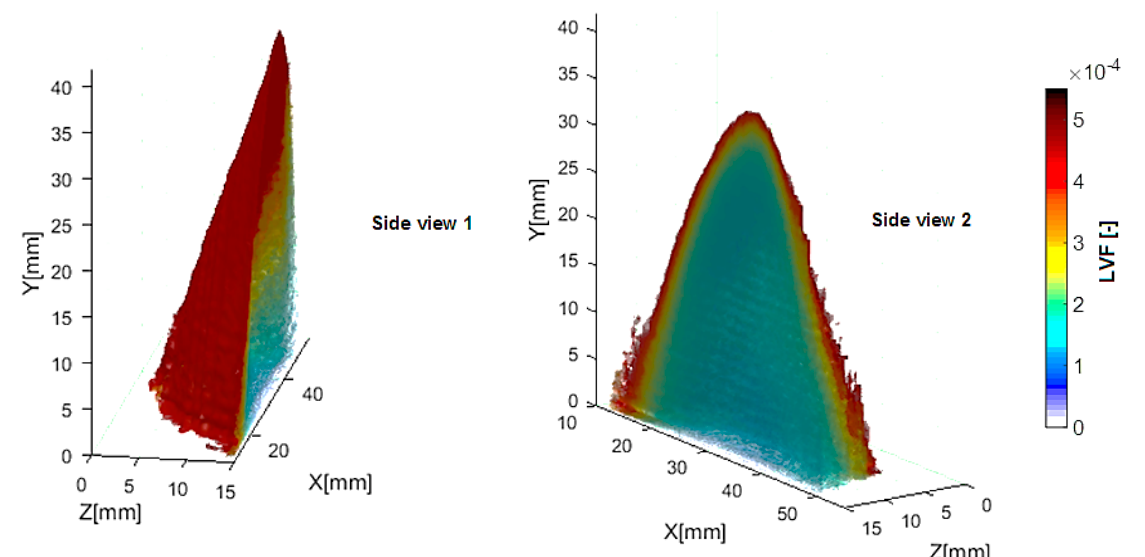
Figure 11. Three-dimensional maps of liquid volume fraction reconstructed using 2D maps shown in Figures 9 and 10.